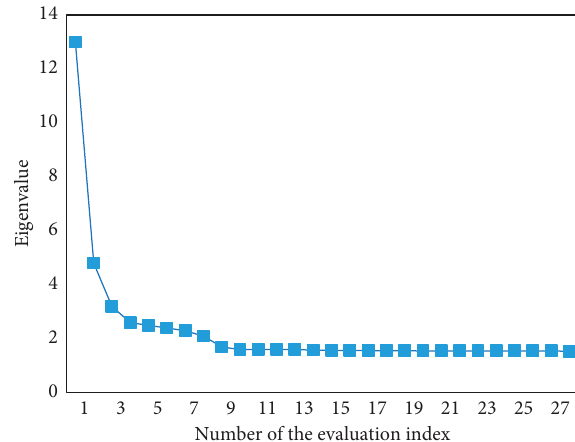
Figure 3: Te screen plot of evaluation